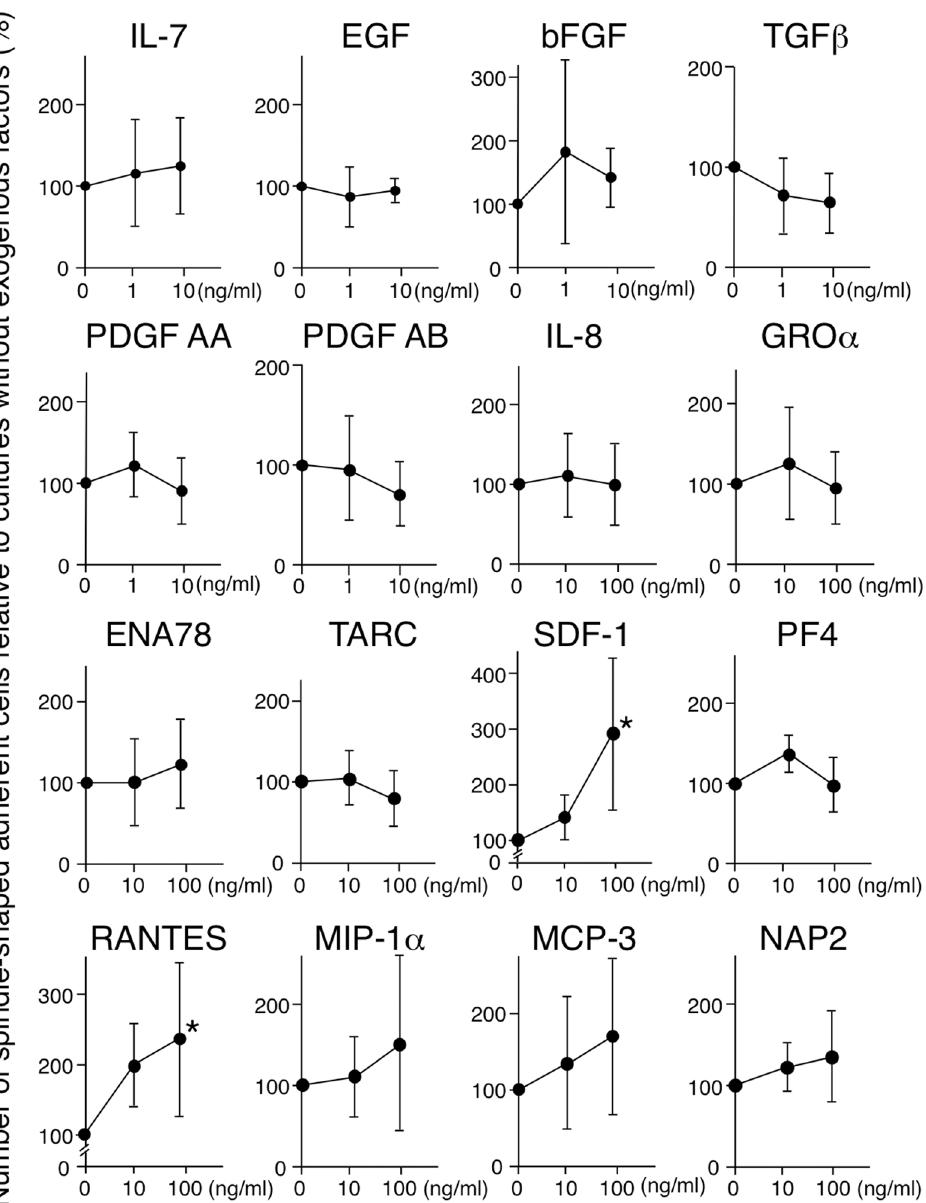
Figure 4. Screening of MOMC differentiation factor(s): 16 candidate cytokines, growth factors, and chemokines. CD14 + monocytes were cultured on fibronectin with or without serial concentrations of various soluble factors released by activated platelets and having a MW , 30 kDa. The generation of spindle-shaped adherent cells was expressed as a proportion (%) of those generated by culturing monocytes alone. Results show the mean and SD of five independent experiments. * P , 0.05, compared with the culture without exogenous factors. IL, interleukin; EGF, epidermal growth factor; bFGF, basic fibroblast growth factor; TGF b , transforming growth factor- b ; PDGF, platelet-derived growth factor; GRO a , growth-related oncogene- a ; ENA78, epithelial cell-derived neutrophil-activating peptide 78; TARC, thymus and activation-regulated chemokine; SDF- 1, stromal cell-derived factor-1; PF4, platelet factor 4; RANTES, regulated upon activation, normal T cell expressed and secreted; MIP-1 a , macrophage inflammatory protein-1 a ; MCP-3, monocyte chemotactic protein-3; and NAP2, neutrophil-activating peptide